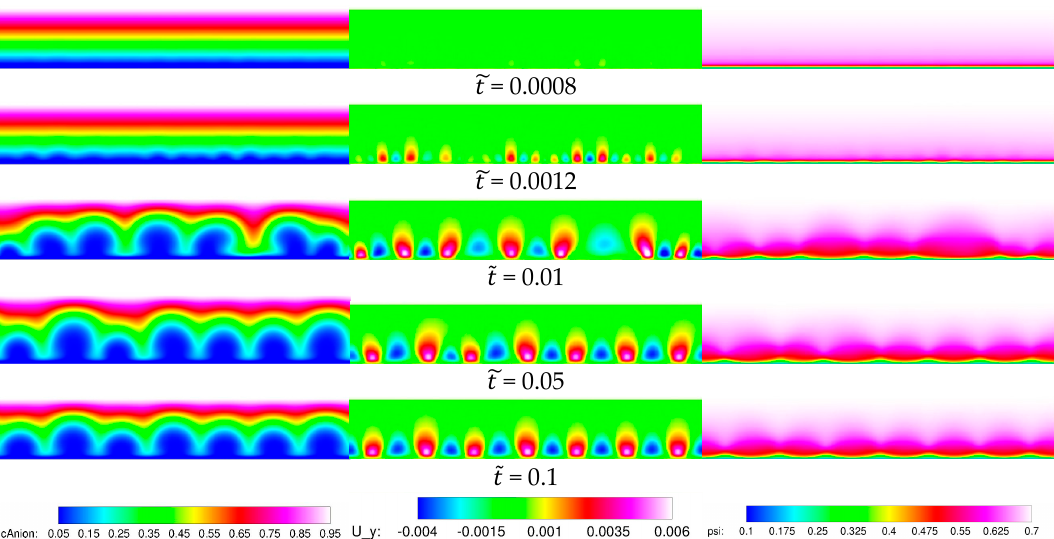
Figure 5. Baseline 2-D case, (cid:101) V = 30. Smooth membrane. From left to right: Anion concentration, vertical velocity in m/s, electric potential in V .